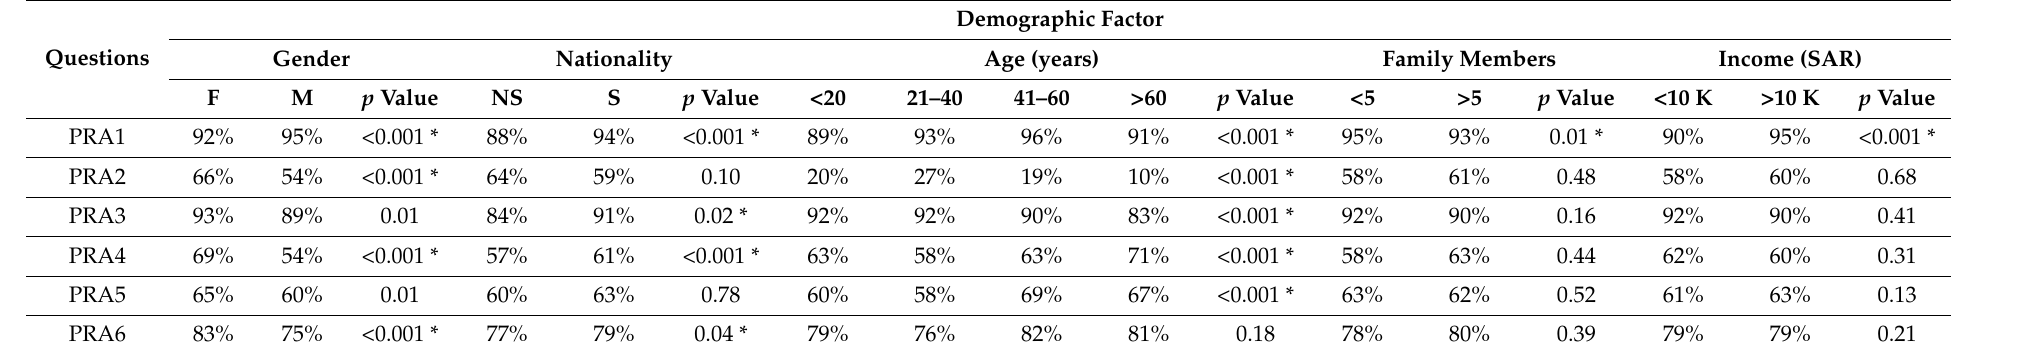
Table 4. Comparison of effect of demographic factors on preventive practice score during COVID-19 in Arabian